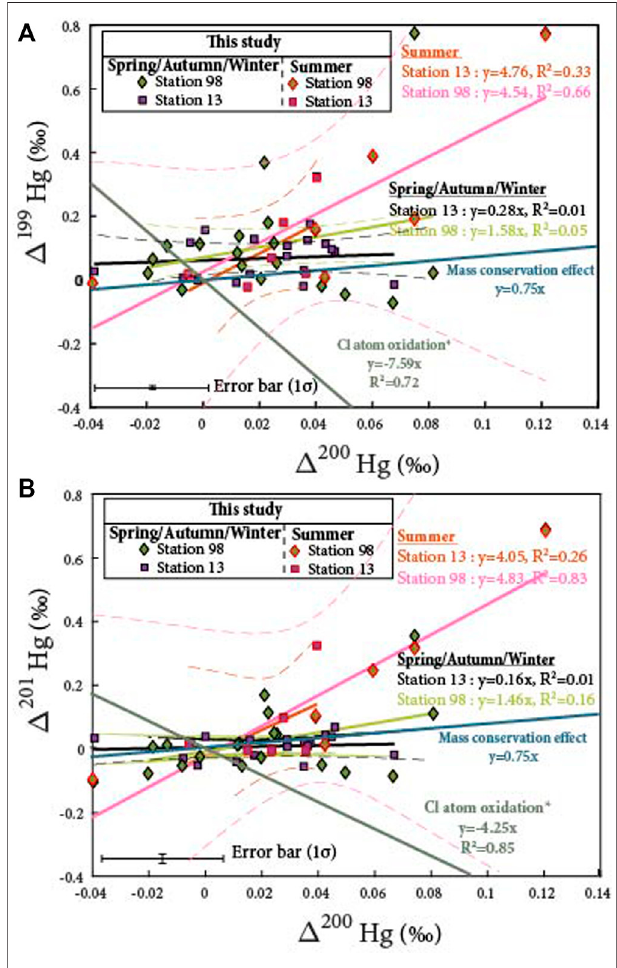
FIGURE 4 | (A) Δ 199 Hg/ Δ 200 Hg and (B) Δ 201 Hg/ Δ 200 Hg ratios from aerosol samples collected in Montreal. Samples are discriminated following the period of sampling: summer vs autumn/winter/spring. The slope for oxidation by Cl atoms is deduced from Sun et al. (2016). The calculation for the one corresponding to the mass conservation effect is described in